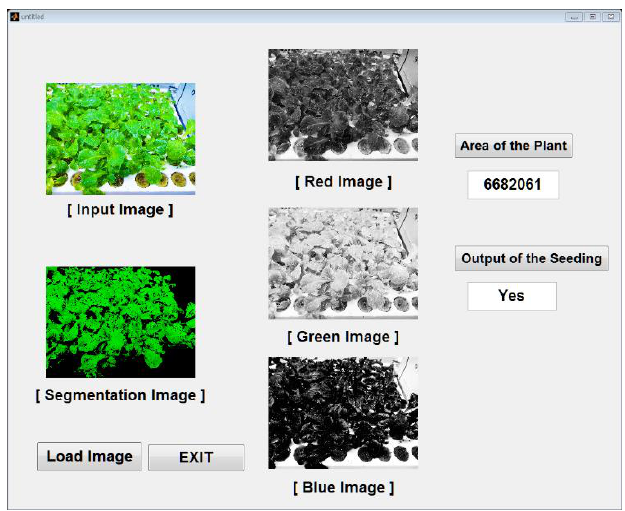
Figure 22. Result of image processing with the proposed algorithm.